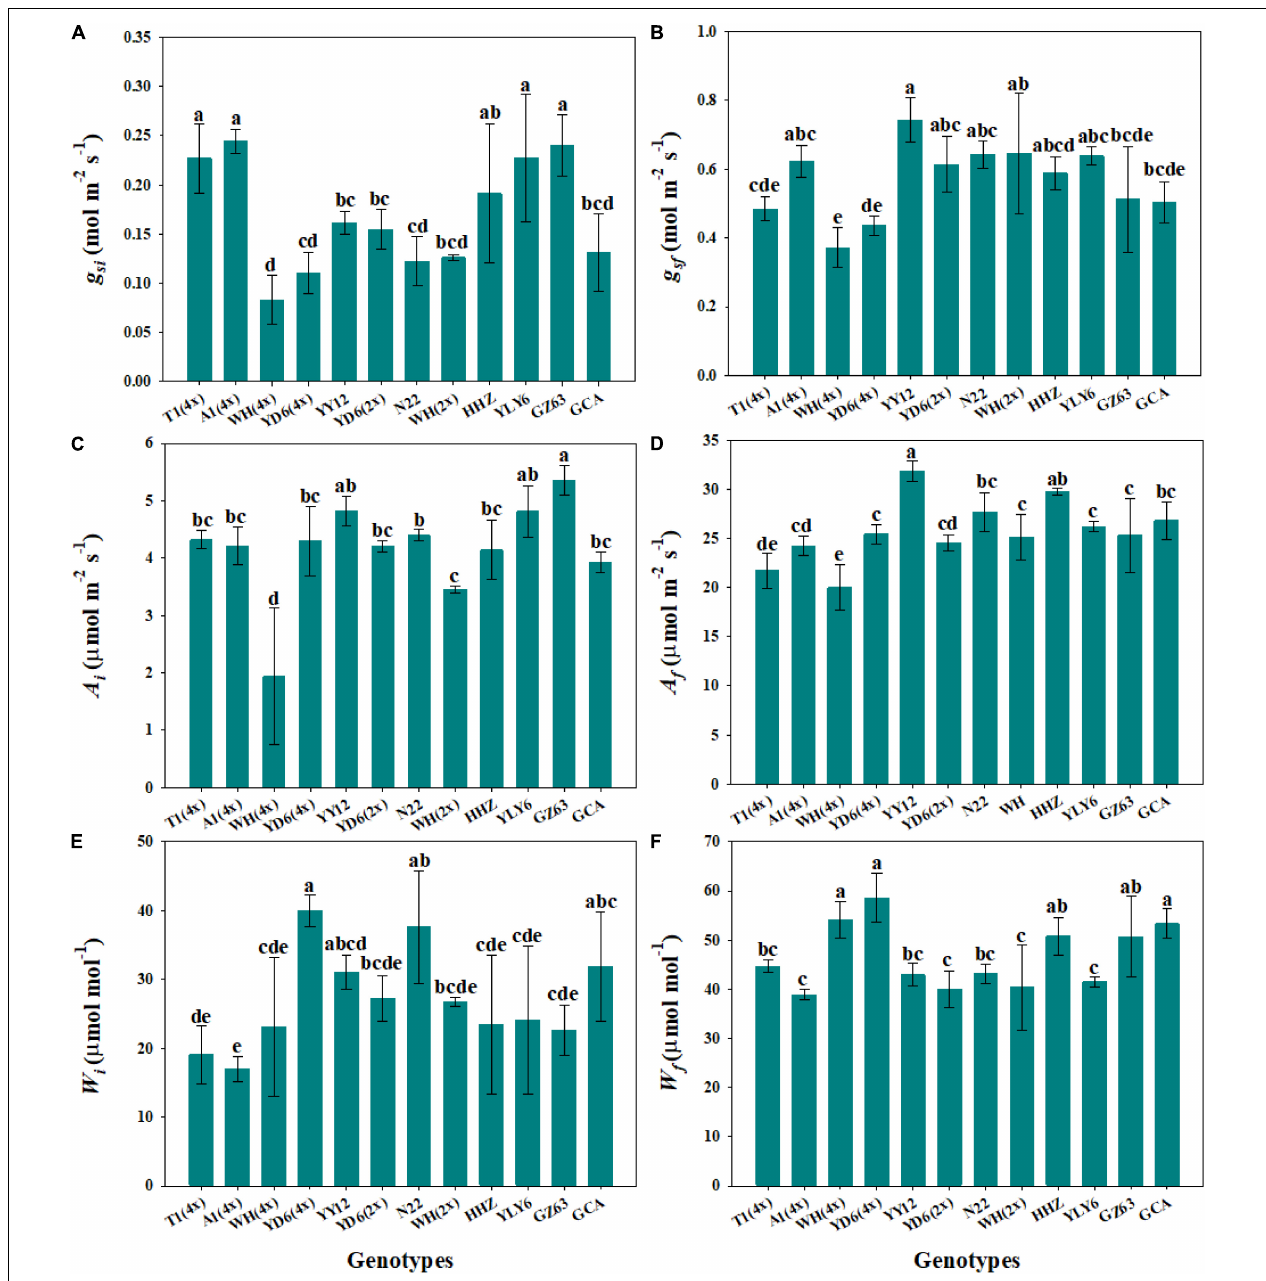
FIGURE 4 | Steady-state gas exchange parameters. (A,B) Initial and final stomatal conductance ( g si and g sf ). (C,D) Initial and final photosynthetic rate ( A i and A f ). (E,F) Initial and final water use efficiency ( W i and W f ) during light induction. Each bar represents the mean ( ± SD) of three replications. Different letters indicate statistically significant differences ( P < 0.05) among twelve rice